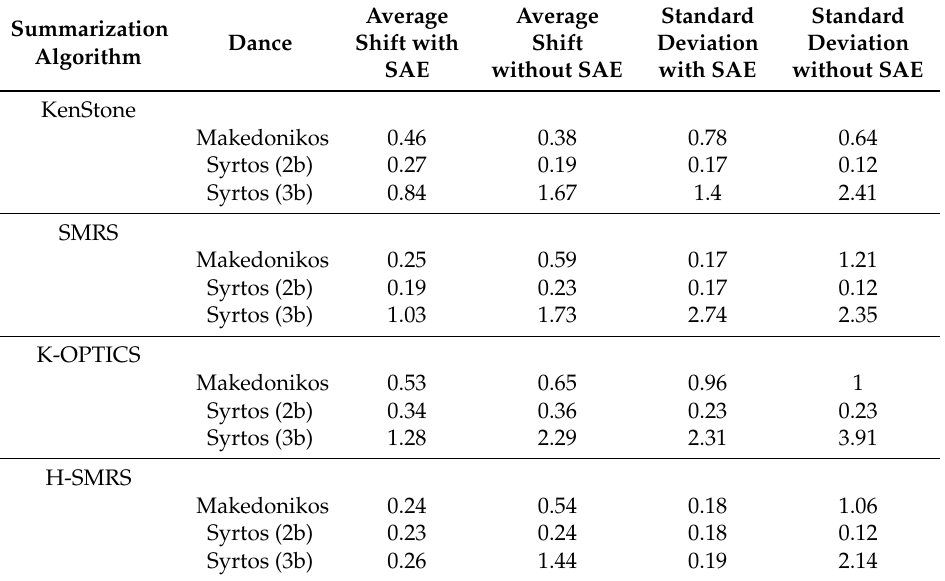
Table 3. Average time shift among the summarization outcomes and the experts’ annotations with and without the Stacked Auto-Encoder (SAE)-based data compression scheme.